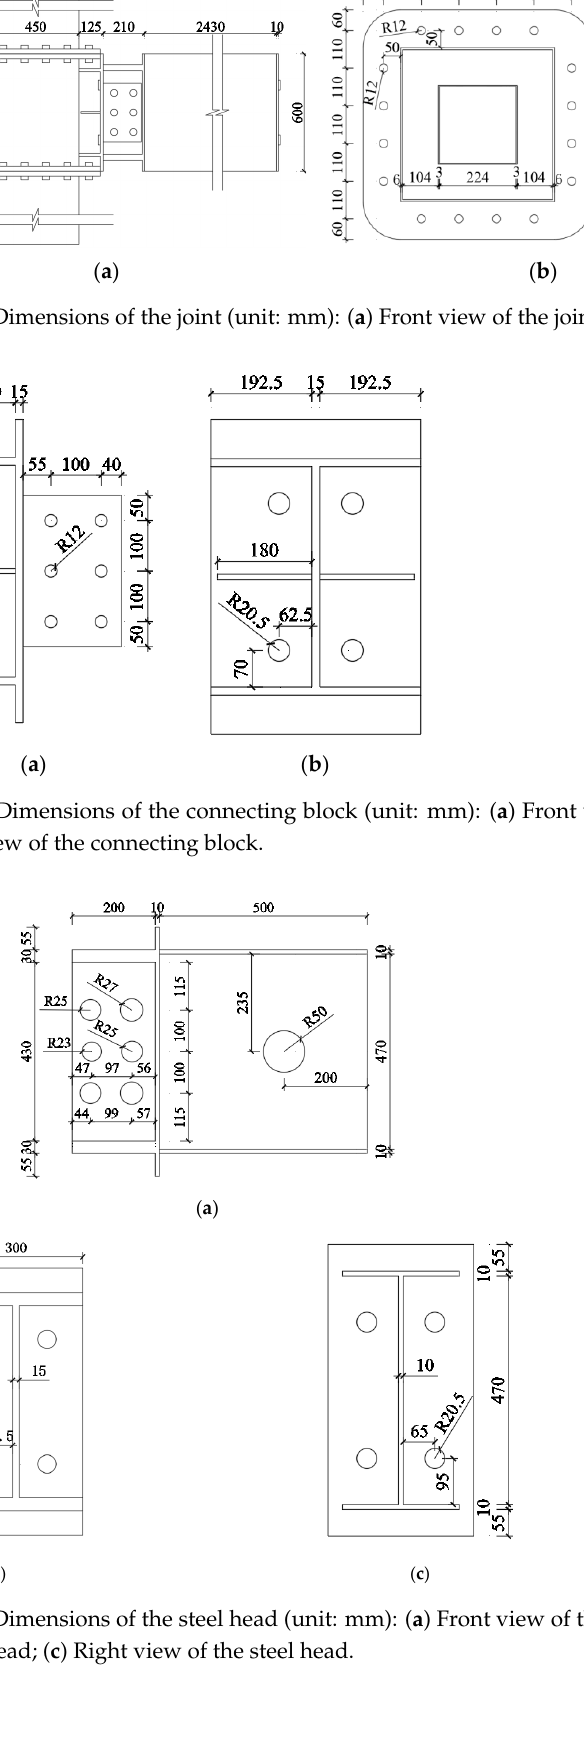
Figure 6. Cross section dimensions of the steel seat.